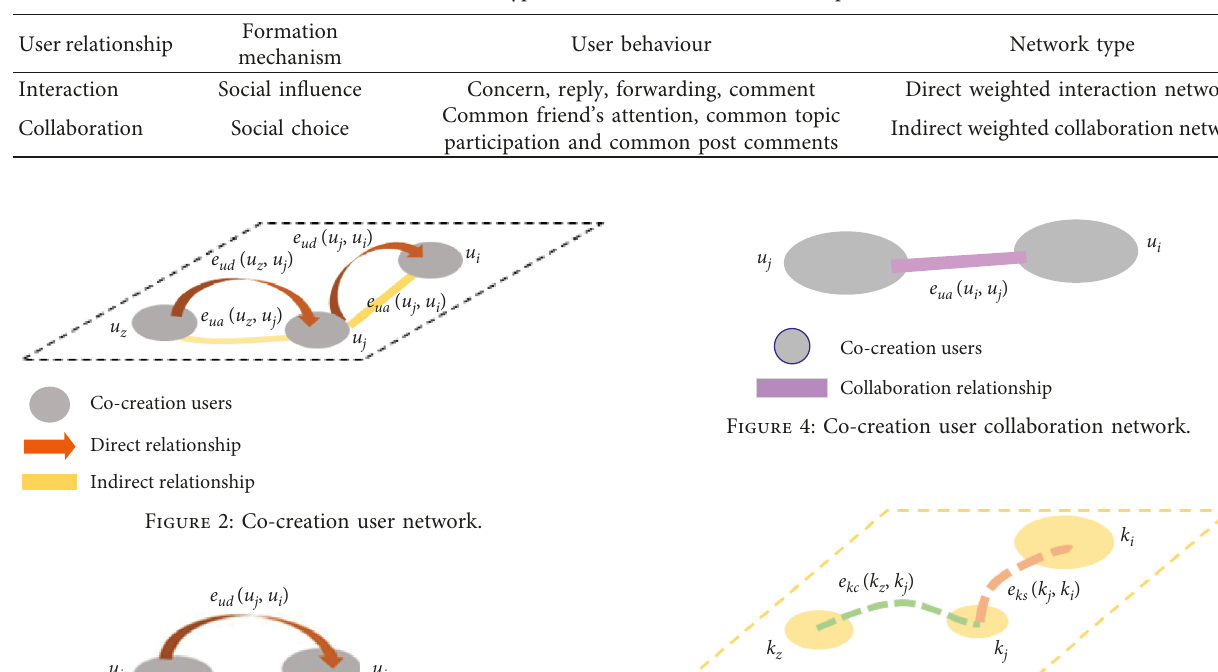
Table 2: Types of co-creation user relationships.